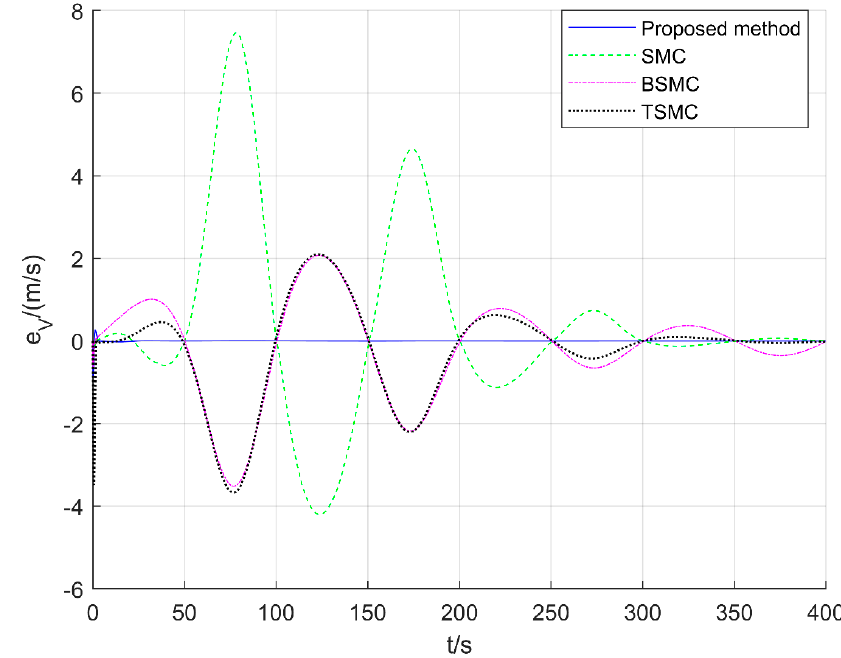
Figure 7. Tracking errors of velocity.